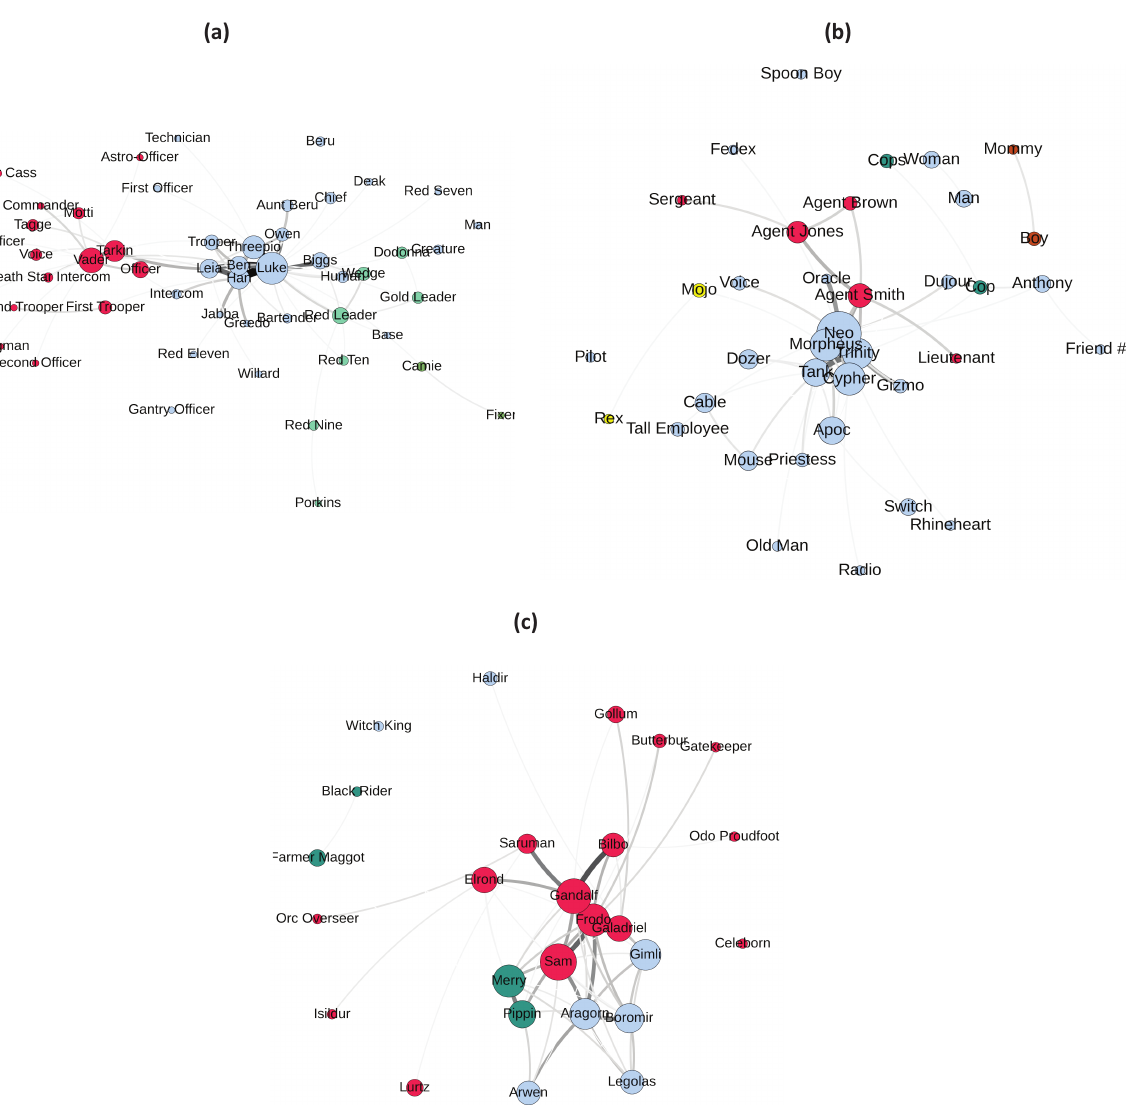
Figure 4. Character dialogue networks: (a) Star Wars: Episode IV : A New Hope ; (b) The Matrix ; (c) The Lord of the Rings: The Fellowship of the Ring . Notes: Node size reflects degree centrality, edge weight captures total co-occurrence in dia- logue, node color illustrates modularity class. Networks are laid out using the force-directed Fruchterman-Reingold algo- rithm. See SM Sections 1 and 2 for scree plots and character dialogue adjacency matrices. Source: